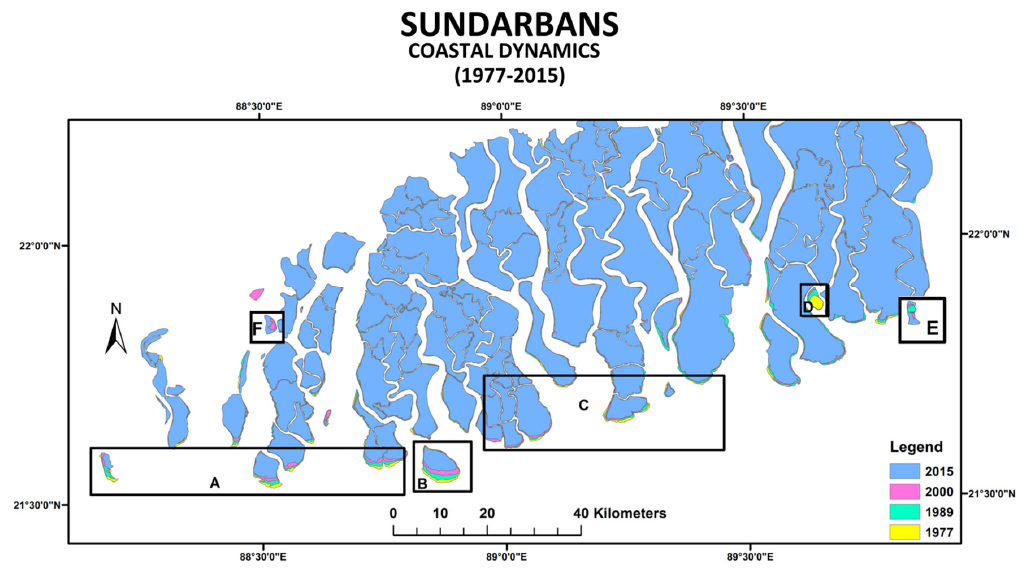
Figure 7. Effects of coastal dynamics (coastal erosion and accretion) showing the change between 1977 and 2015 in the Sundarbans coast.